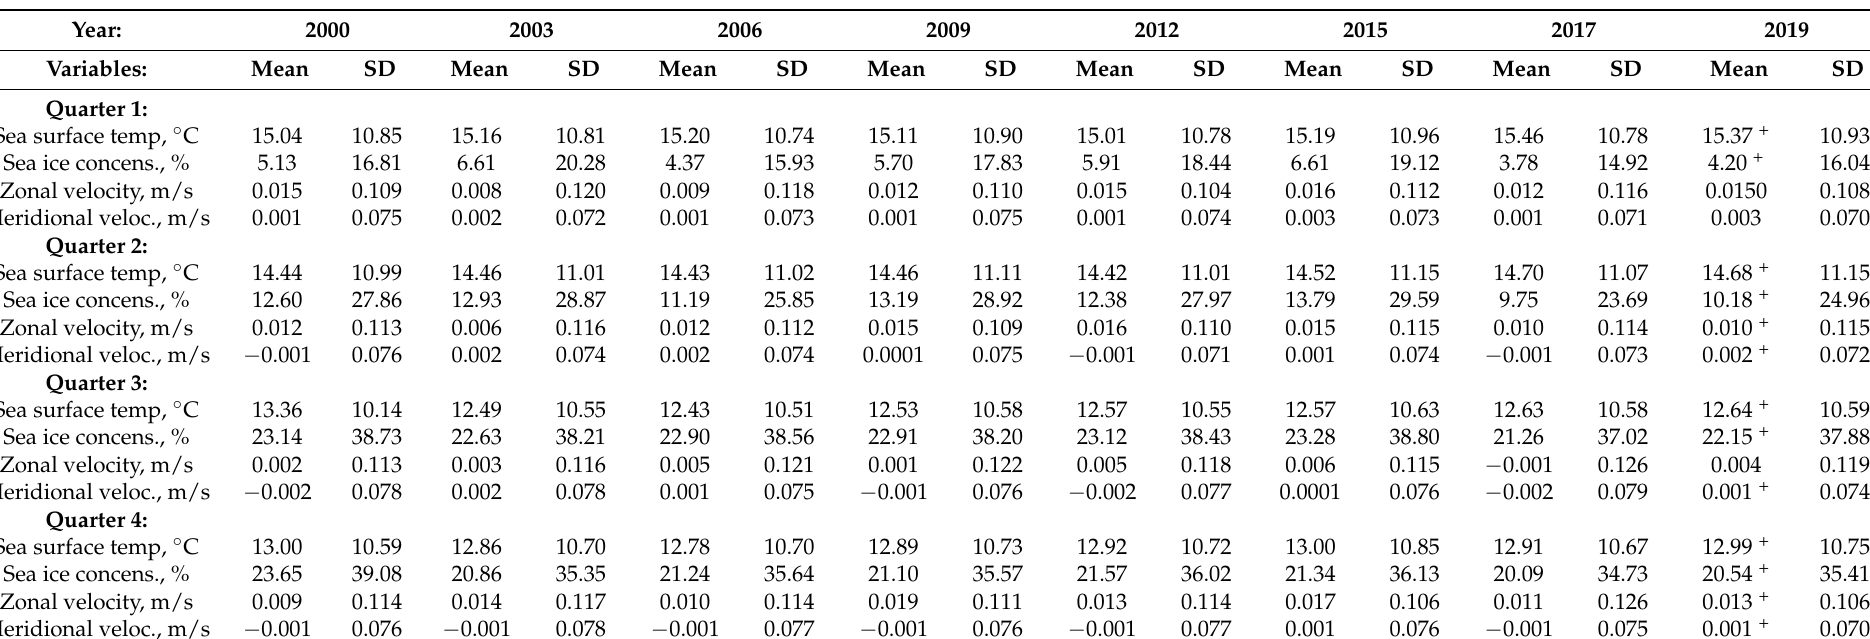
Table 2. Sample means and standard deviations of quarterly sea surface temperatures, sea ice concentrations, and zonal and meridional ocean current velocities